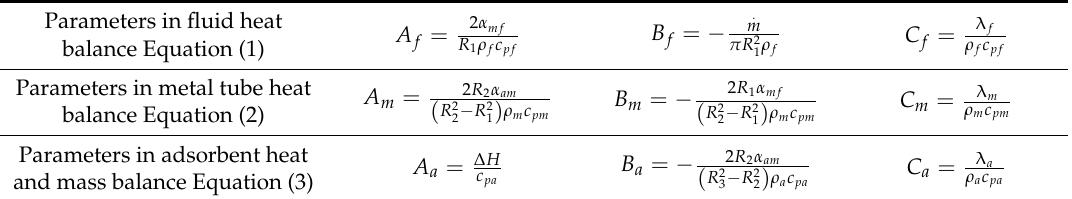
Table 1. Constant parameters from the set of heat and mass balance partial differential equations of the adsorbent